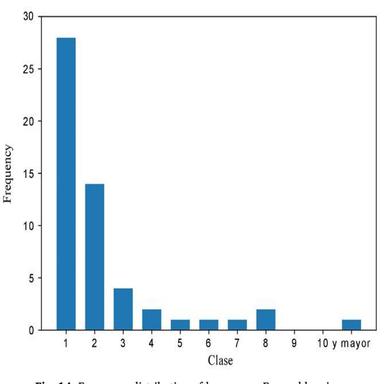
Frequency distribution of hang-ups – Esmeralda mine.